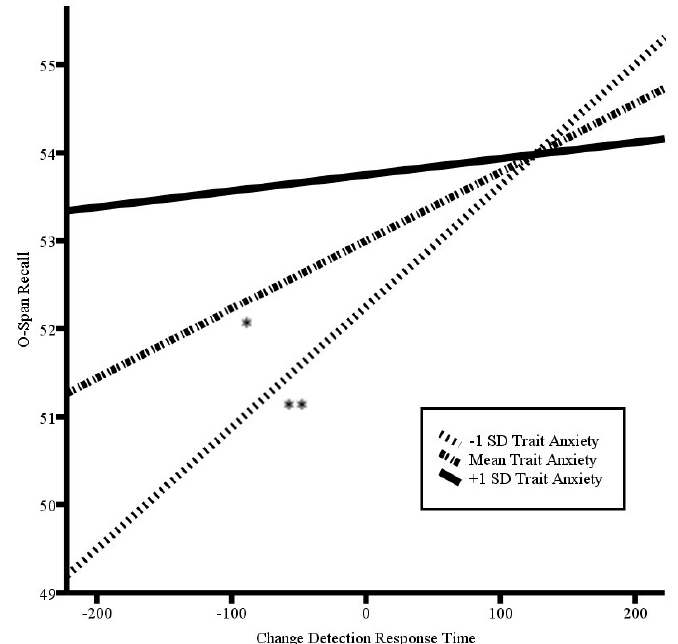
Figure 1. Plot of simple slopes of the centered change detection response time by trait anxiety level in predicting O-Span recall; ** p < 0.001; * p < 0.05. Higher scores on the O-Span recall represent greater attentional control. Higher scores in change detection response time indicate slower response time relative to the average detection speed (zero) and, therefore, less vigilance. Table 3. Moderation by Initial SCL Reactivity (SCL-R) of the Relation between the Change Detection Reaction Time and O-Span Recall, Controlling for Trait